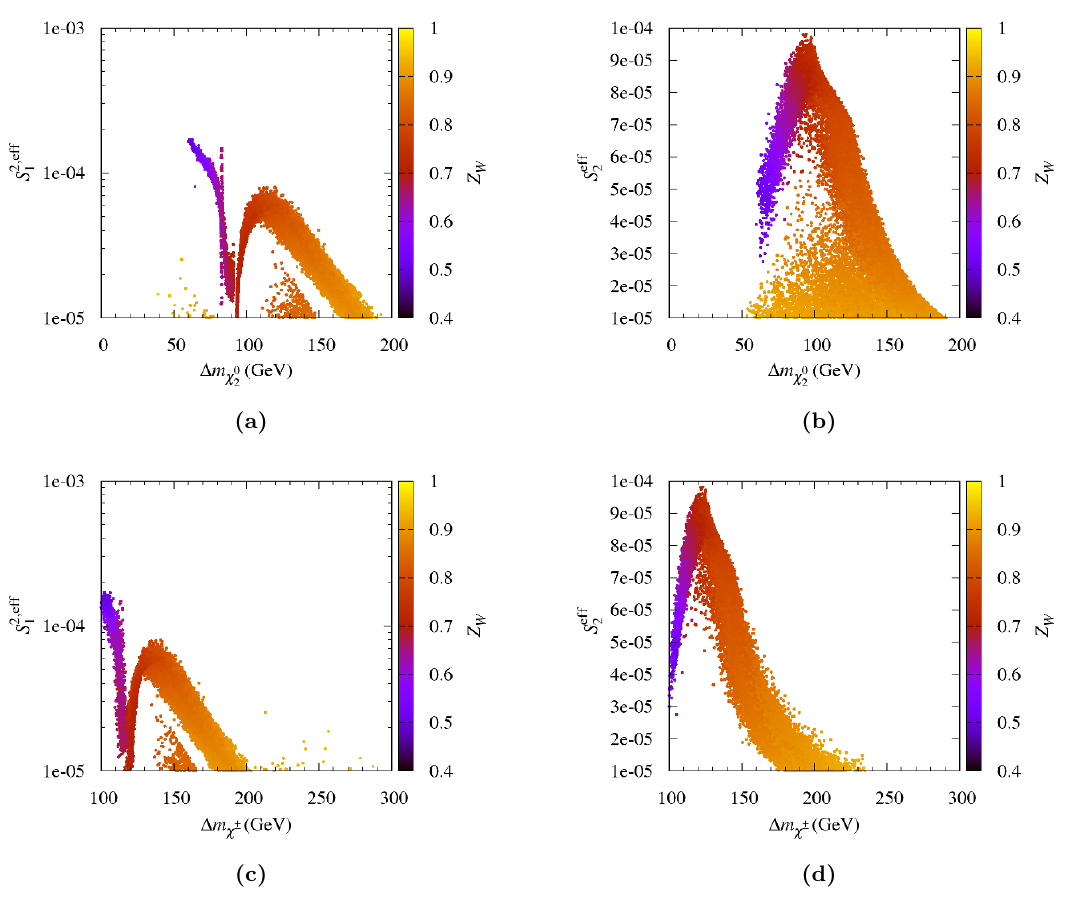
Figure 4. (a) S 2 ; e(cid:11)